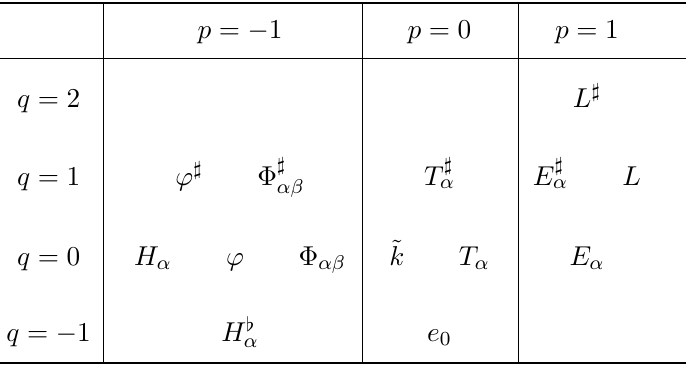
Table 6 . Basis elements of S when g + is the a(cid:14)ne extension of g